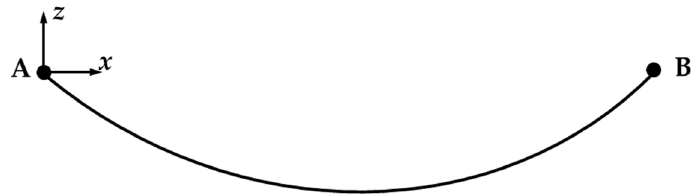
Figure 8. The bending moment distribution of different segment lengths along the length direction.